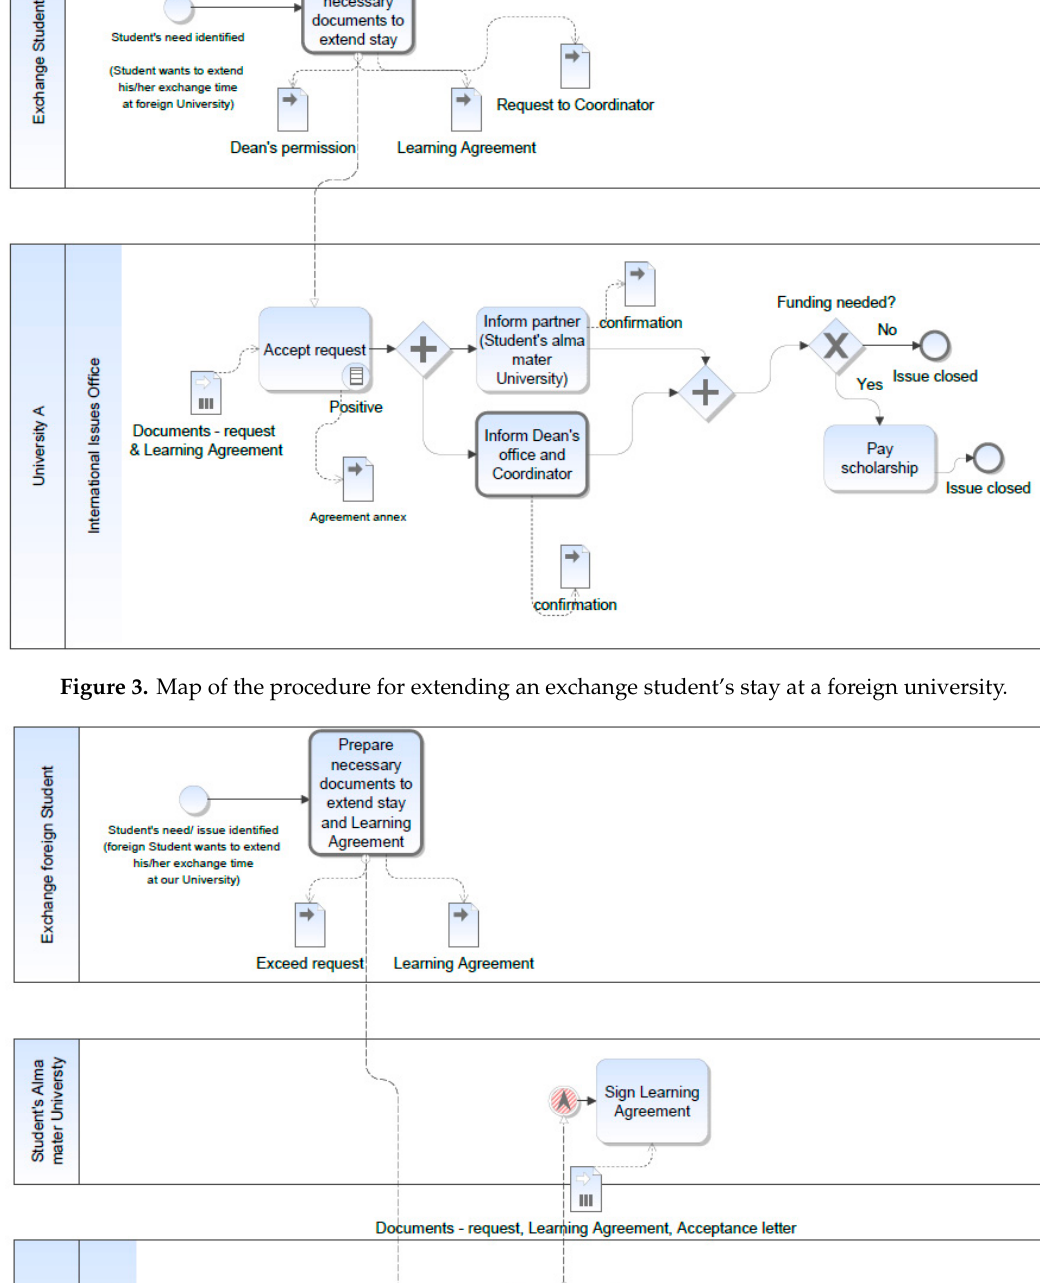
Figure 5. Map of the procedure of a student returning to his/her alma mater.